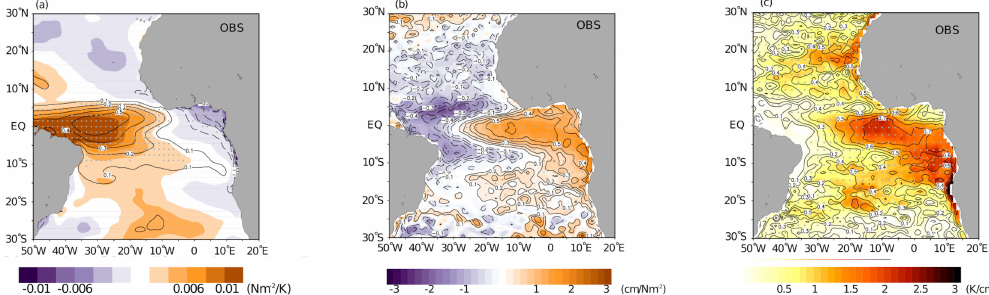
Figure 5. Three elements of Bjerknes Feedback (BF). ( a ) Correlation (contour, IC, 0.1) between ATL3 index (OISST) and zonal wind stress (ERA-Interim) and regression of zonal wind stress on ATL3 index. ( b ) Correlation (contour) between sea surface height (AVISO) and zonal wind stress (ERA-Interim) averaged over 2 ◦ S–2 ◦ N and 35 ◦ W–20 ◦ W and regression of sea surface height onto zonal wind stress averaged over 2 ◦ S–2 ◦ N and 35 ◦ W–20 ◦ W. ( c ) Correlation (contour) between grid-wise sea surface temperature (OISST) and sea surface height (AVISO) and regression (color) of sea surface temperature onto sea surface height. For the calculation, all 12-month anomalies (detrended) from monthly climatology are used. Similar figures are given by [63].